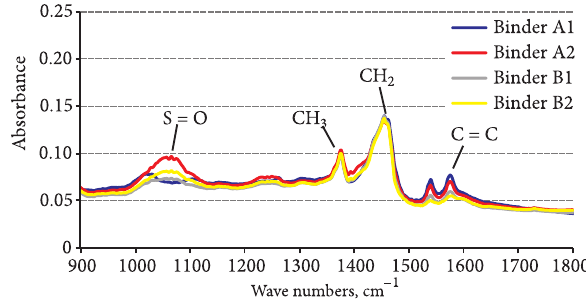
Fig. 5. Infrared spectrum of binders A1, A2, B1 and B2 Table 6. Indexes of un-aged binders